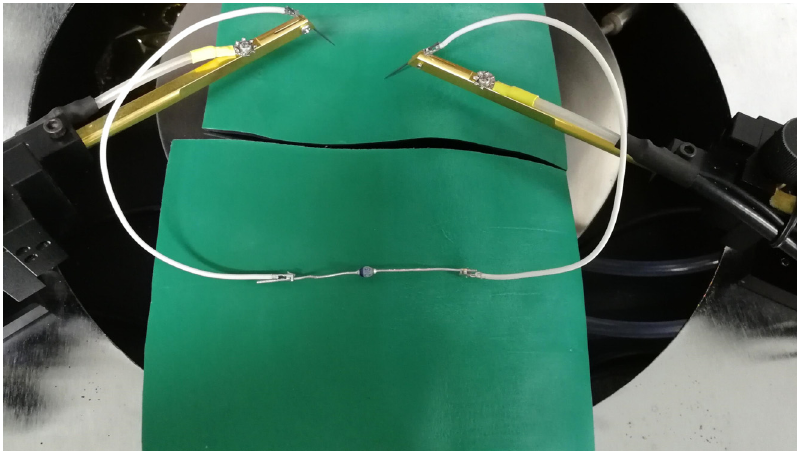
Figure 10. The detail of the diode’s junction capacitance parameter test.